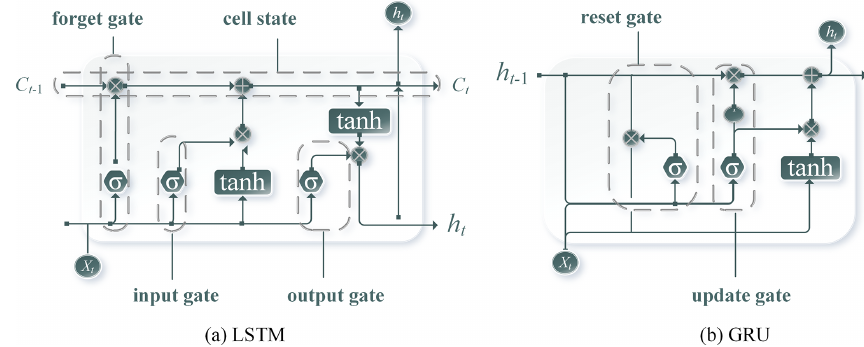
Figure 2. Structure of an (a) LSTM and (b) GRU